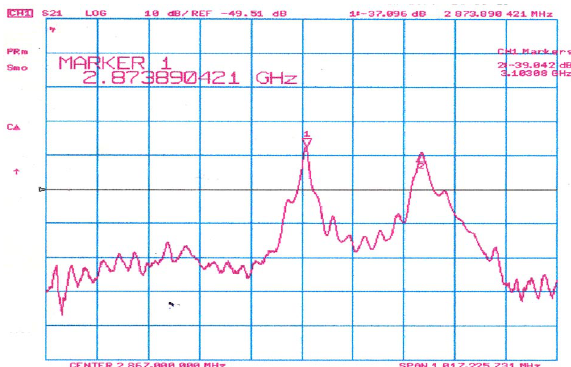
FIG. 2. (Color) Frequency spectrum of the coupled cells of the rf